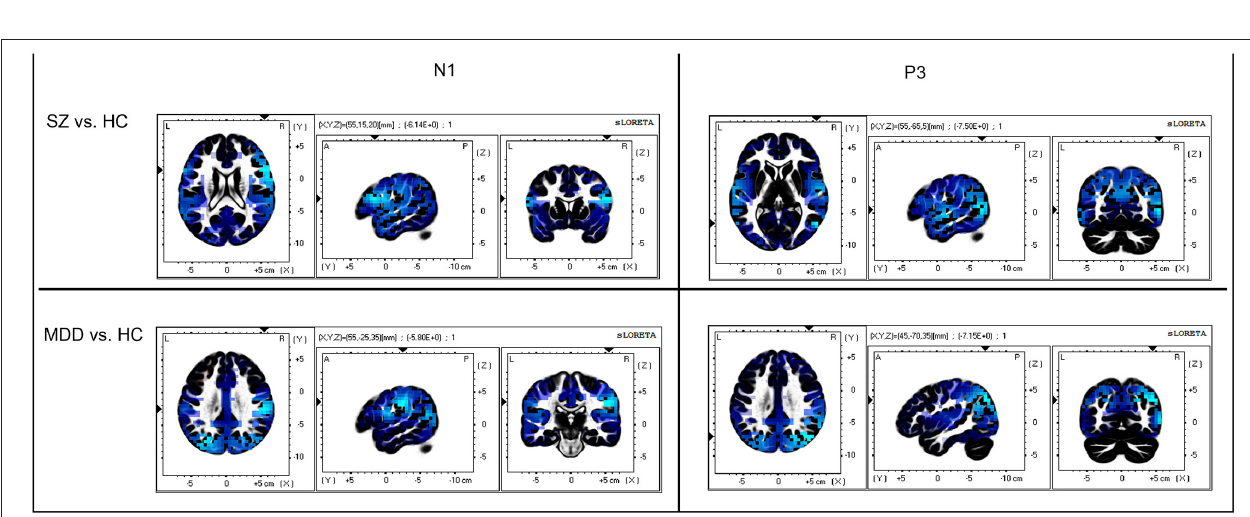
FIGURE 1 | AP300 with brain phenotyping. (A) is the radar chart with sum of amplitudes. (B) is the peak and latency. (C) illustrates topographical map of N1 and P3 between patients and healthy controls.